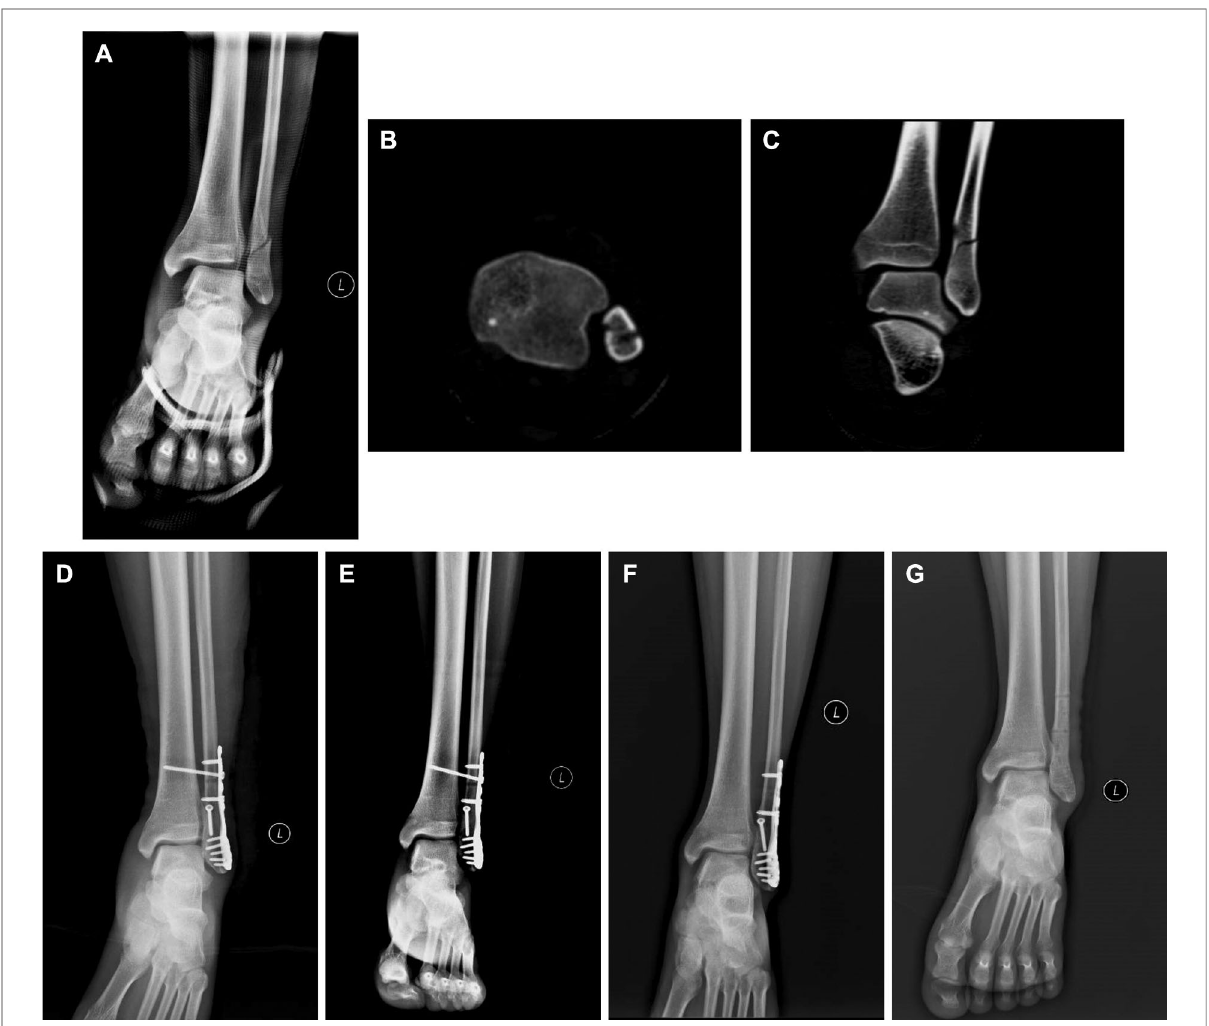
FIGURE 3 A Male patient with Weber type B, Lauge – Hansen SER-III, bimalleolar equivalent fracture treated with fi bula ORIF and trans-syndesmotic screw fi xation. Preoperative anteroposterior x-ray image ( A ), axial CT scan image ( B ), and coronal CT ( C ) scan image showed the fi bular fracture, increased medial malleolus clear space and inferior tibio fi bular syndesmotic disruption. ( D ) Postoperative anteroposterior image showed the reduction of fi bular fracture, medial malleolus clear space, and distal tibio fi bular joint. One month ( E ), one year ( F ), and post internal fi xation removal ( G ) anteroposterior x-ray images did not show any displacement or dislocation, no ankle osteoarthritis was found either. ORIF, open reduction and internal fi xation; CT, computed